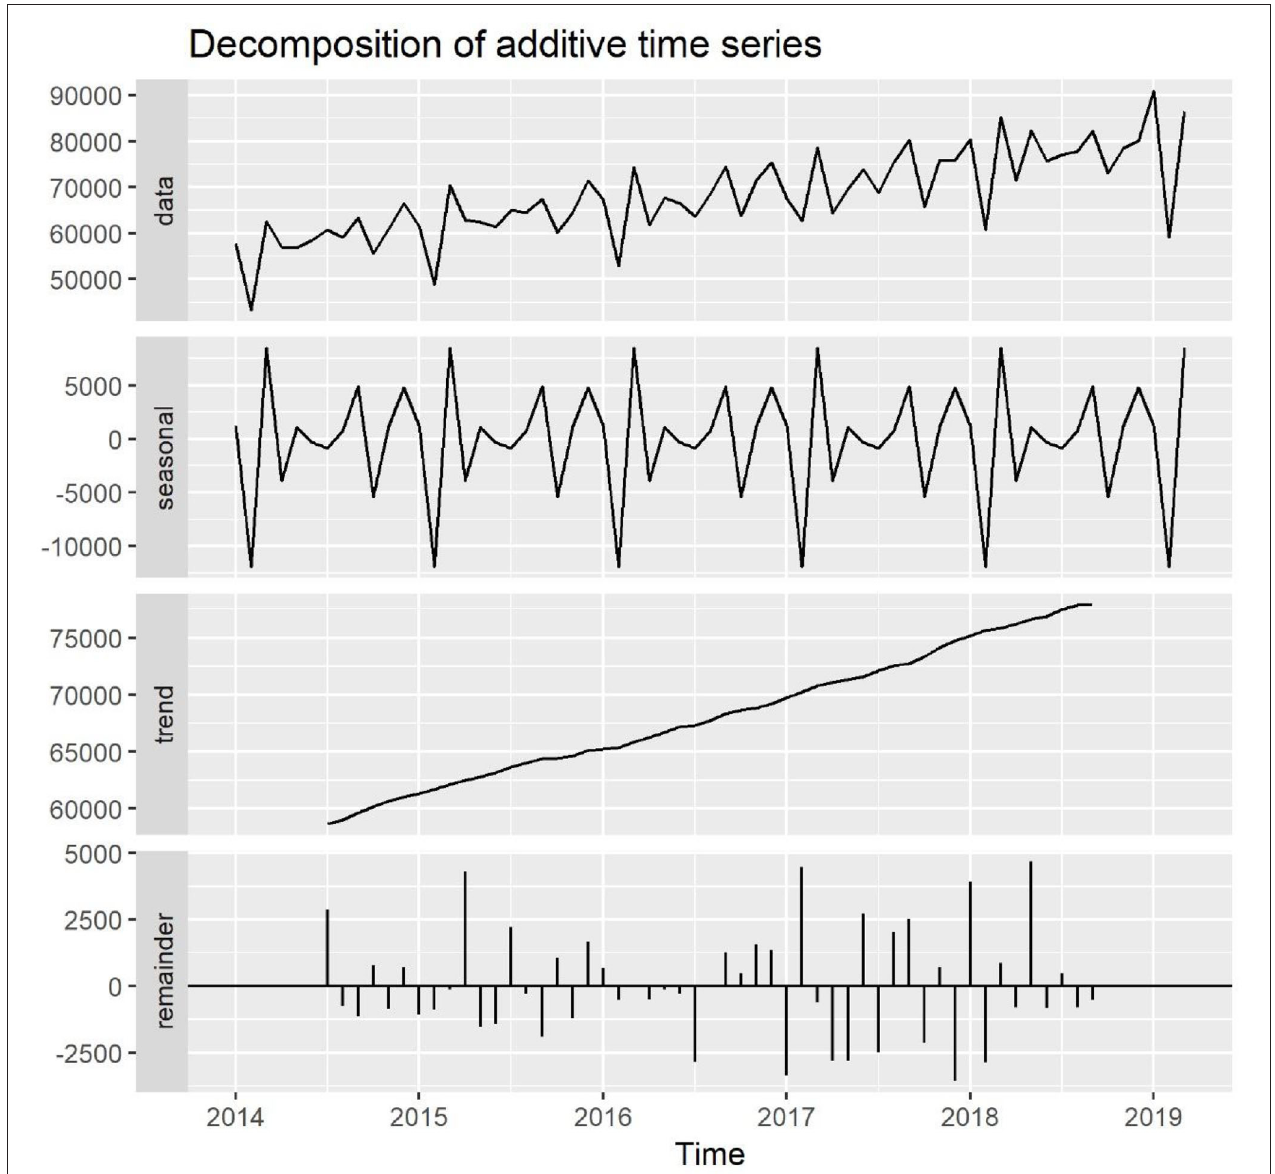
FIGURE 1 | General and seasonal trends of total outpatients at the Shanghai Mental Health Center from January 2014 to March